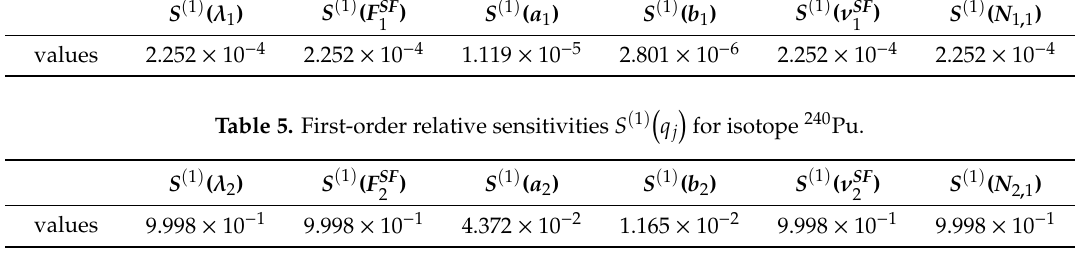
Table 4. First-order relative sensitivities S ( 1 )